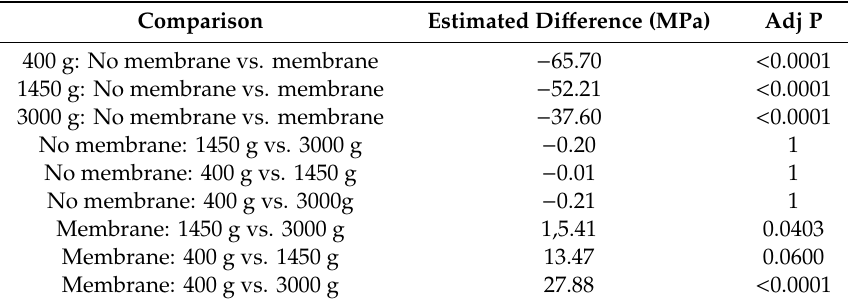
Table A3. Comparison of mean modulus by membrane and centrifuge rates.